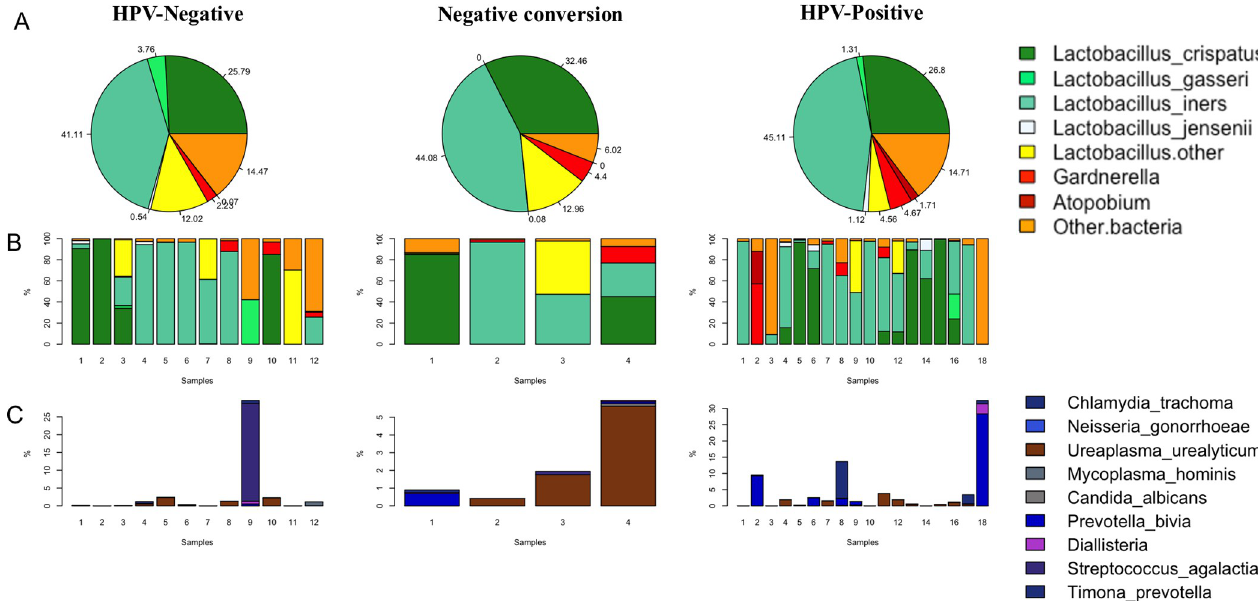
Fig 2. Relative abundance (%) of species of microbes in the three cohorts. Legend: (A) Pie charts show the relative microorganism abundance between the three cohorts. Proportion was calculated from the average value of abundance for each group by CST type. (B) Bar charts showing the proportion of dominant species in each sample. Selected microorganism level was selected from the CST type to show the relative abundance and characterization. (C) Bar charts showing the proportion of pathogenic microorganism species as indicated in the key.